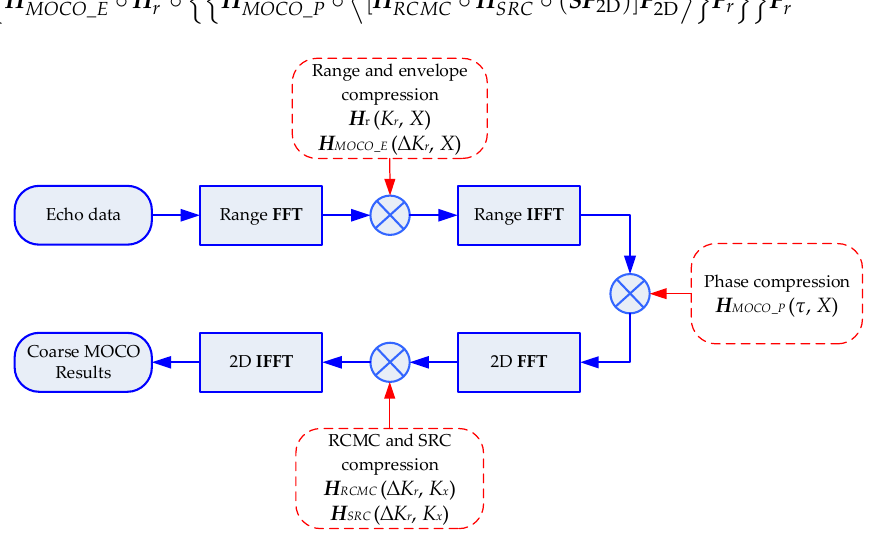
Figure 2. Flowchart of the proposed one-step MOCO operator.